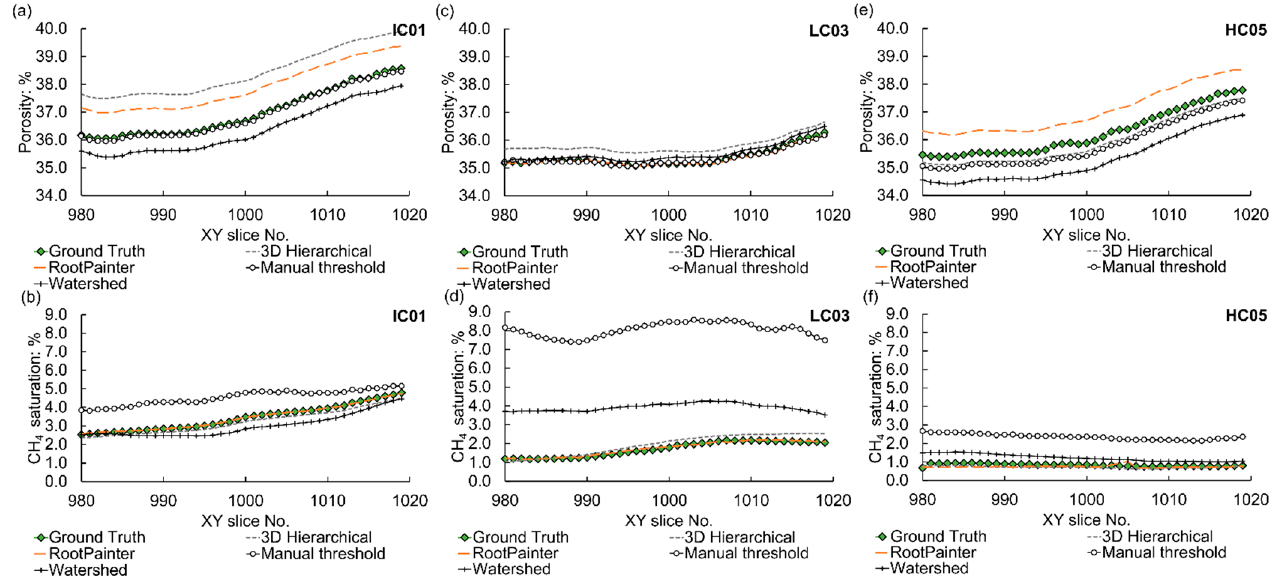
Figure 10. Porosity and CH 4 gas saturation profiles for the central 40 XY slices of data sets IC01 ( a , b ), LC03 ( c , d ) and HC05 ( e , f ) derived using image segmentations obtained from 3D hierarchical and RootPainter U-Net models trained on sub-volumes of IC01 ( a , b ) and LC03 ( c – f ). Parameters derived from manual thresholding and watershed segmentation methods also shown.